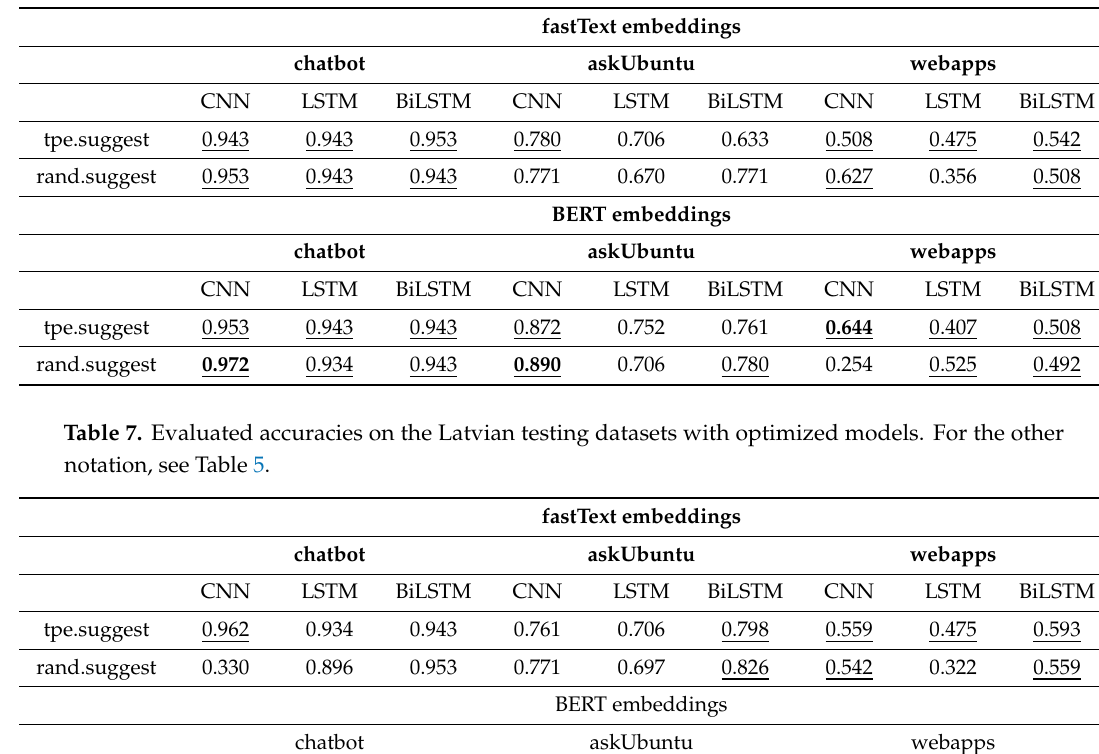
Table 6. Evaluated accuracies on the Estonian testing datasets with optimized models. For the other notation, see Table 5.